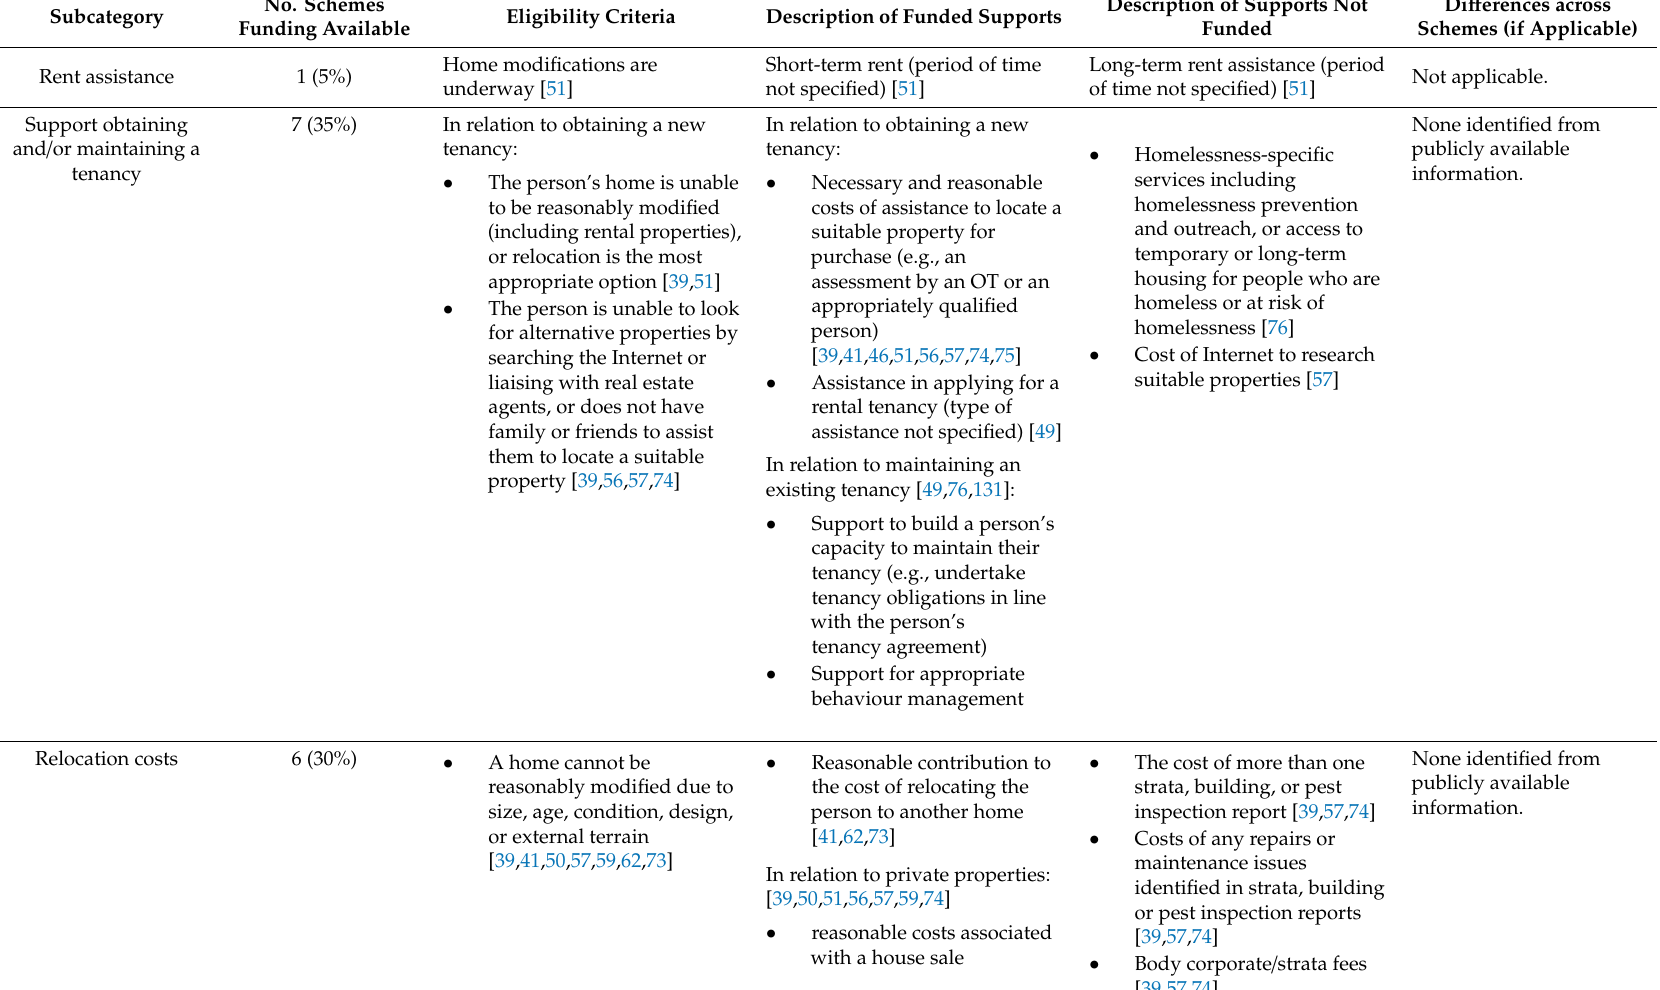
Table 3. A Comparison of Tenancy Funding across the